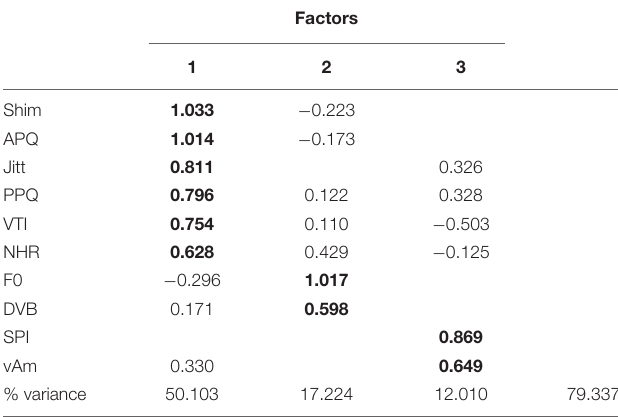
TABLE 1 | Matrix of the results of analyzing main components used for acoustic voice characteristics with Promax